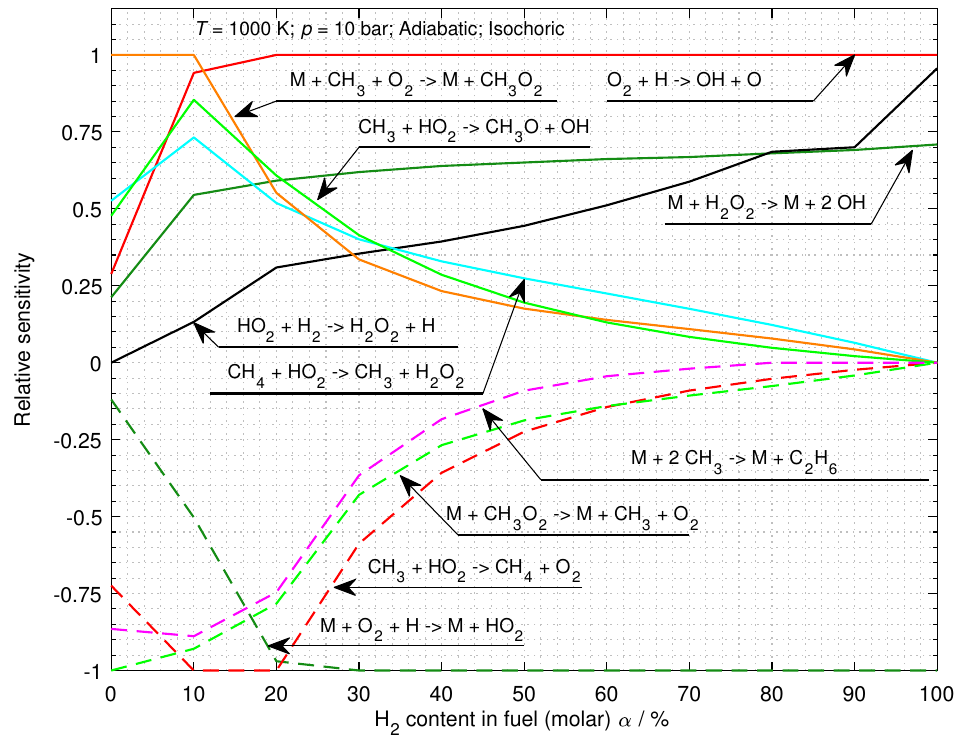
Figure 4. Sensitivity analysis of stoichiometric mixtures with varying CH 4 /H 2 ratio α . Simulations were performed with AramcoMech 3.0 [68]. Full lines: positive sensitivities and dashed lines: negative